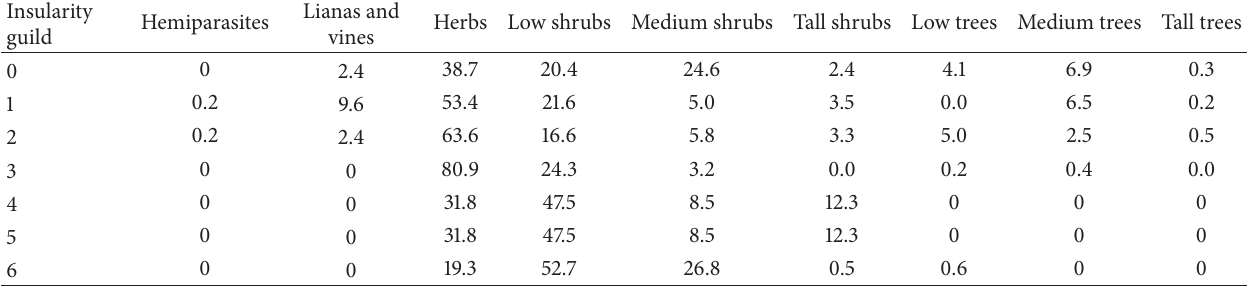
Table 2: Percent of vascular flora within each major life form type from inselberg insularity guilds. Insularity Hemiparasites guild